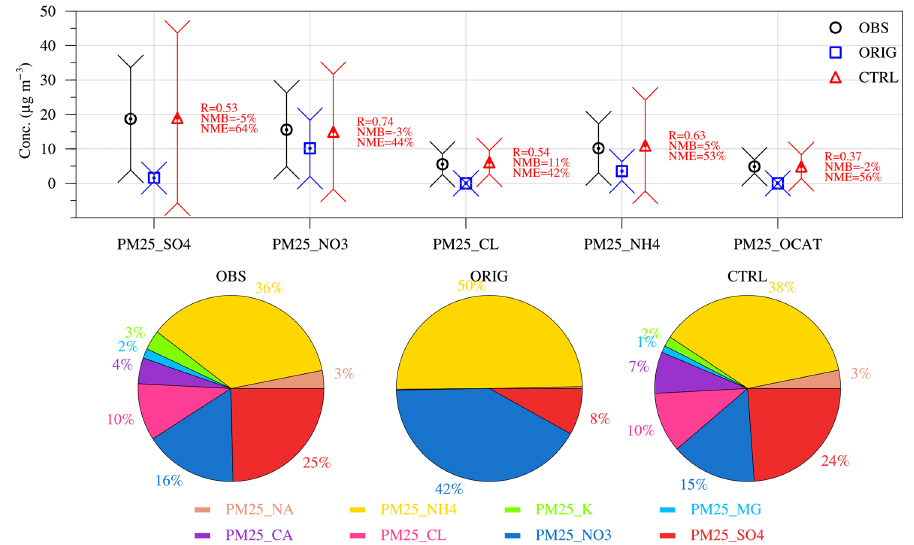
Figure 2. The significant improvement of simulations in the CTRL scenario compared to the ORIG scenario. Bottom panel: observed (OBS) and simulated (scenarios of ORIG and CTRL) mean electric charge fractions for fine particulate sulfate (PM25_SO4, using SO 2 − the surrogate), nitrate (PM25_NO3), ammonium (PM25_NH4), chloride (PM25_CL), sodium (PM25_NA), potassium (PM25_K), calcium (PM25_CA), and magnesium (PM25_MG) at the Beijing TSU site during January 2013. Top panel: observed (OBS) and simulated (scenar- ios of ORIG and CTRL) concentrations (both average and standard deviation are shown) for fine particulate sulfate (PM25_SO4), nitrate (PM25_NO3), chloride (PM25_CL), ammonium (PM25_NH4) and other cation components (PM25_OCAT = PM25_NA + PM25_K + PM25_CA + PM25_MG) at the Beijing TSU site during January